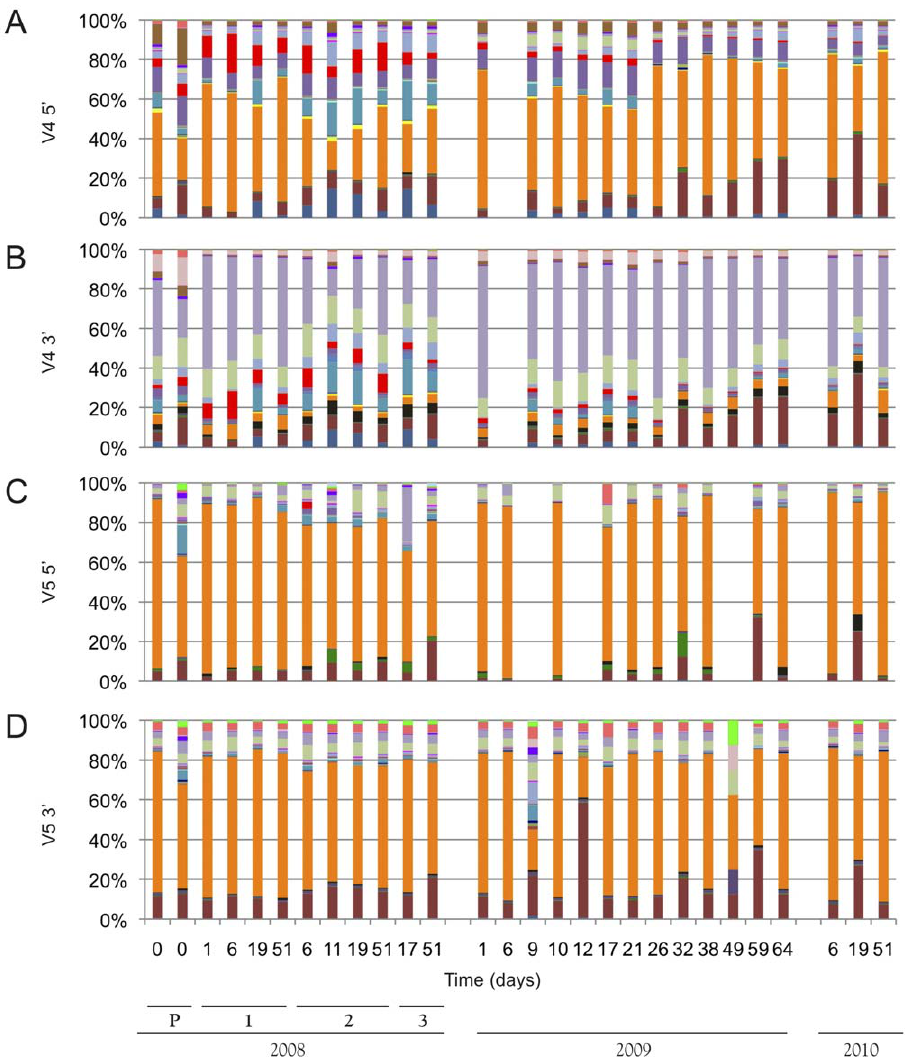
Figure 2. Bacterial community structure determined by sequencing of the V4 (Panels A,B) and V5 (Panels C,D) domain of 16S rRNA. Panel A: V4 5 9 . Panel B: V4 3 9 . Panel C: V5 5 9 . Panel D: V5 3 9 . Labeled bars indicate batch numbers (P, 1–3) and vintage (2008, 2009, 2010). y -axis represents relative OTU abundance. P indicates 2008 press-pan samples. Missing samples were removed due to inadequate sequence coverage. For color key, see Figure S2.